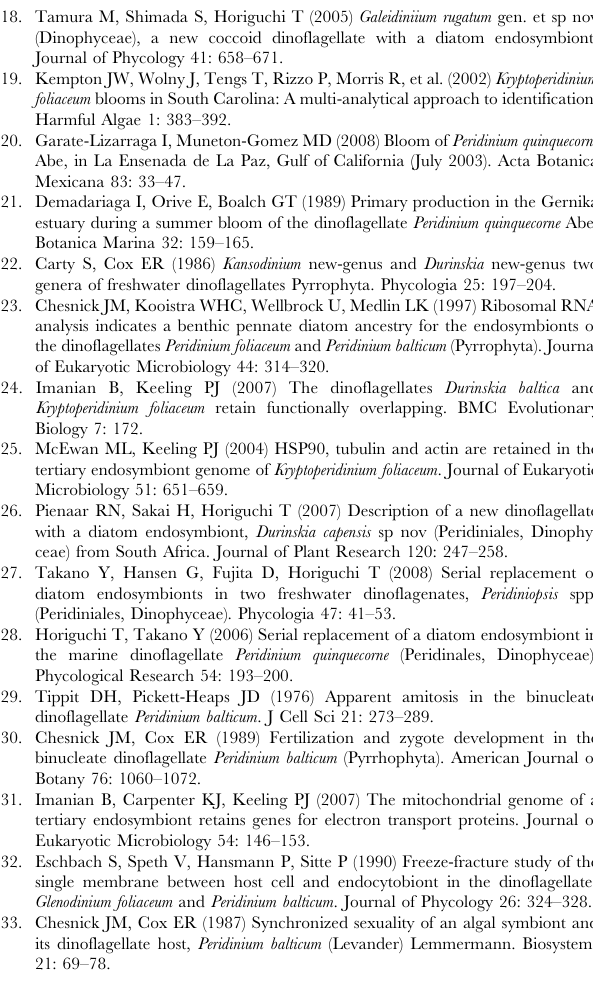
Figure S3 Conserved residues found in SerC1 and SerC2. The conserved residues found in the SerC1 and SerC2 recombinases encoded in the plastid genomes of Kryptoperidinium foliaceum and other site-specific serine recombinases. The sequences of SerC2 were manually added to the Conserved Domain Database (CDD) alignment for SerC1. The conserved residues with specific functions are marked with a number sign ( # ) above the alignments. Shaded residues indicate invariable sites among all the recombinases in the alignment, and the long rectangular boxes highlight conserved sites among all the recombinases in the alignment except one. Found at: doi:10.1371/journal.pone.0010711.s003 (1.74 MB